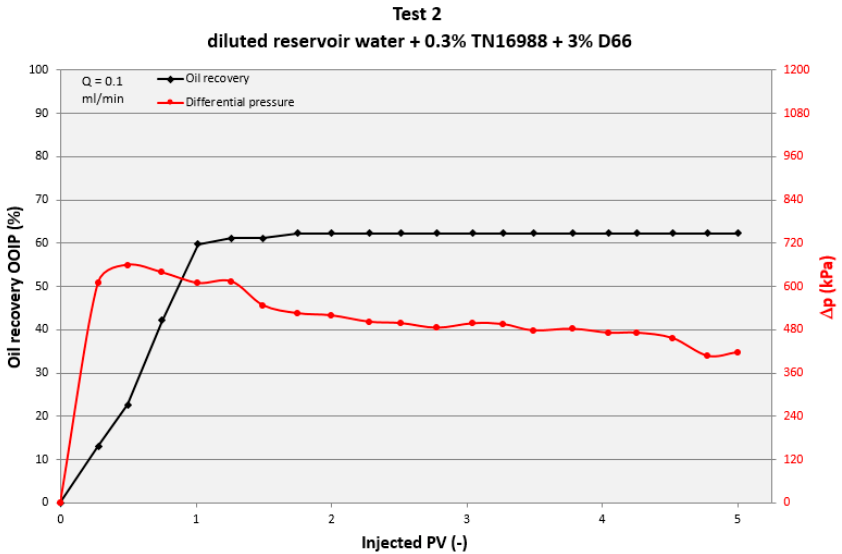
Figure 5. Recovery factor for diluted reservoir water with the addition of 0.3% polymer and 3% nanoemulsion.